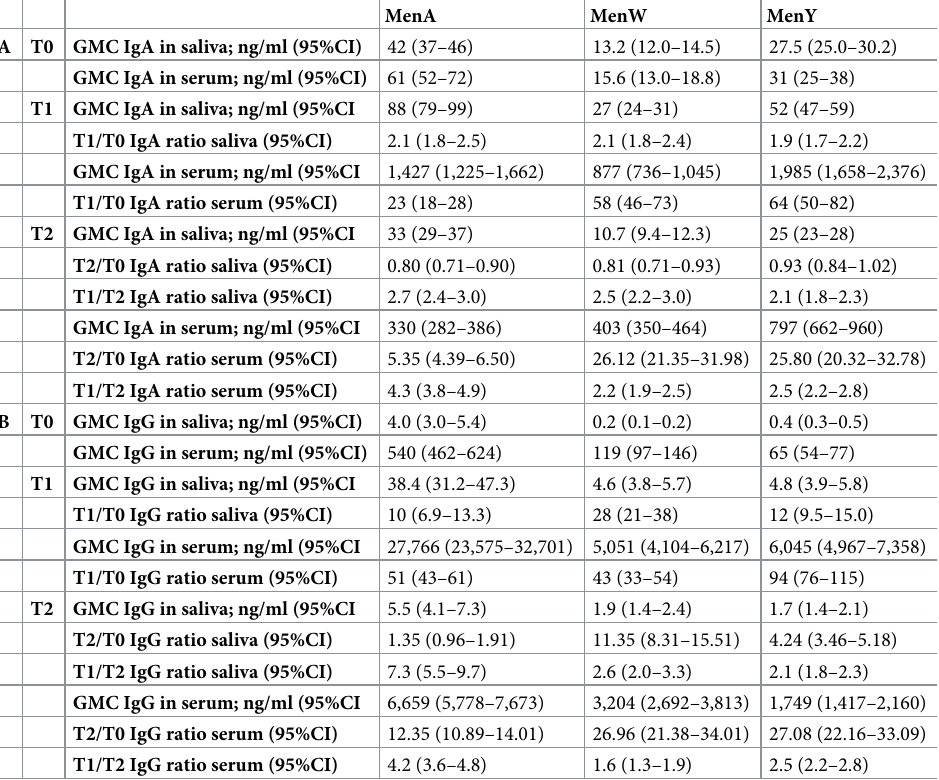
Table 1. Geometric mean concentration (GMC) of meningococcal serogroup A-, W- and Y-polysaccharide spe- cific IgA (A) and IgG (B) in saliva and serum before (T0), one month (T1) and one year (T2) after adolescent